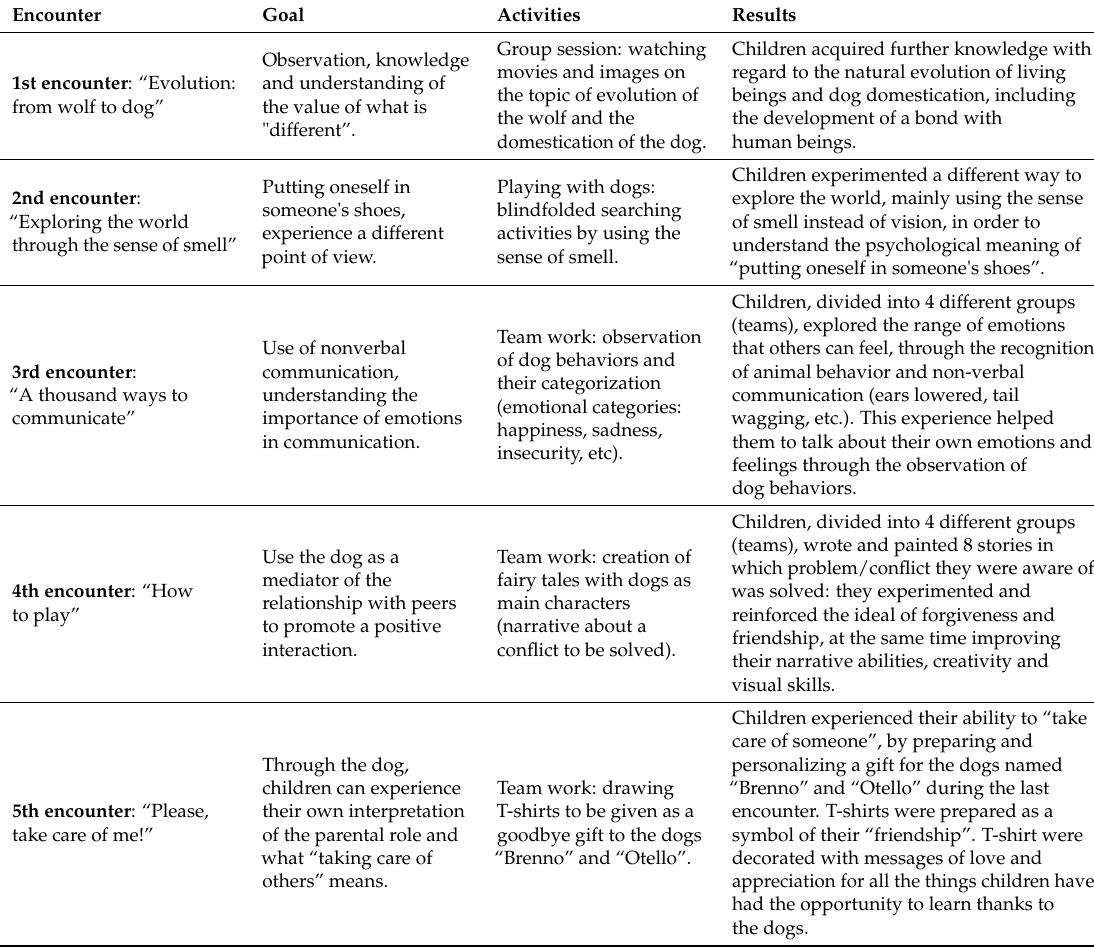
Table 1. Activities proposed during the dog-assisted